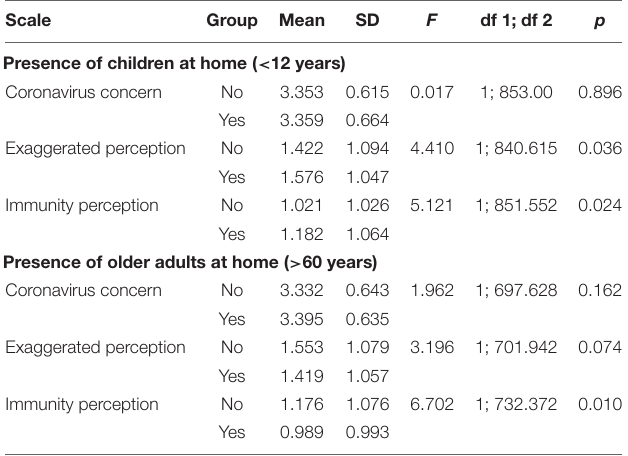
TABLE 3 | Descriptive and comparative statistics for CAS-10 scores according to household configuration.